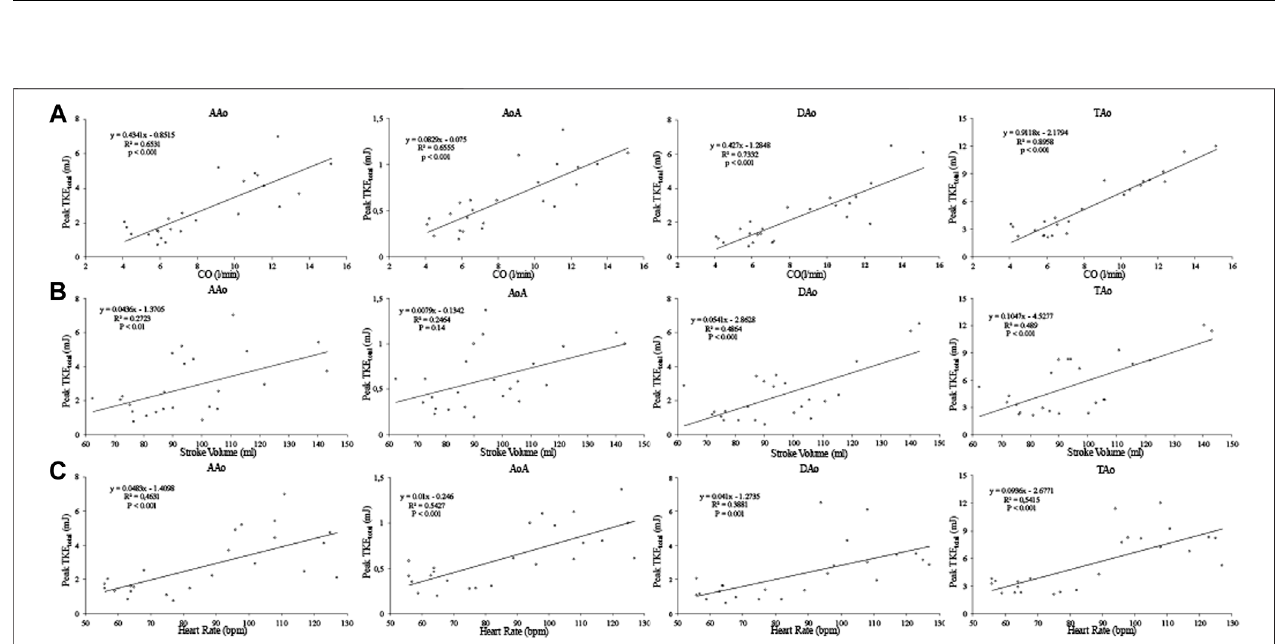
FIGURE5| Therelation betweenPeakTKE total andCO (A) ,leftventricularstrokevolume (B) ,andheartrate (C) foreachofthe12healthysubjectsinthefouraortic regions at rest and with dobutamine infusion. CO, cardiac output; AAo, ascending aorta; AoA, arcus aorta; DAo, descending aorta; TAo, thoracic aorta.